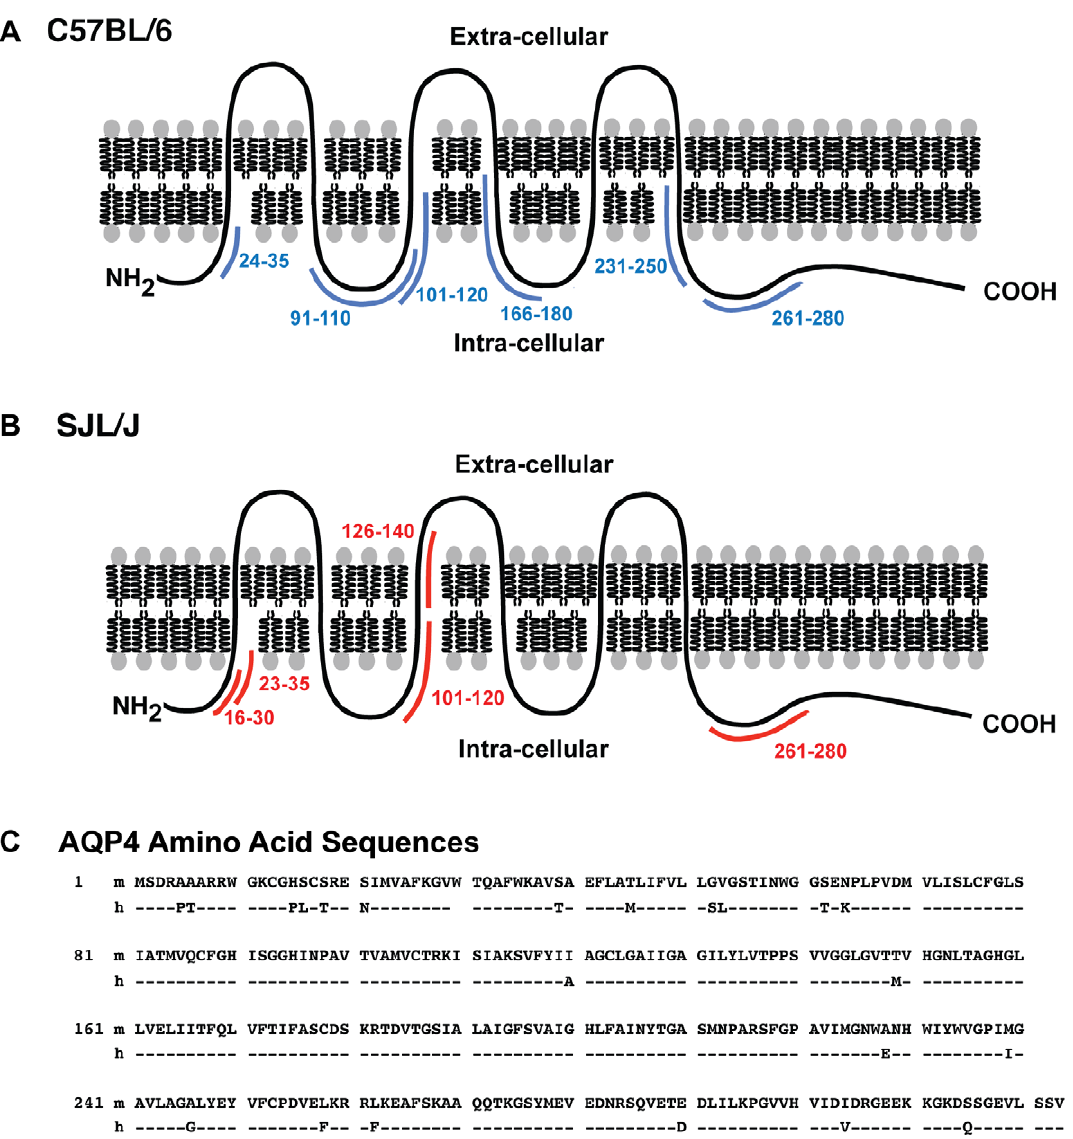
Figure 2. Localization of identified murine AQP4 T cell epitopes. AQP4 peptides that elicited proliferative responses in (A) C57BL/6 and (B) SJL/J mice are located within putative transmembrane and cytoplasmic domains. (C) Sequences of human (hAQP4) [34] and murine [17] AQP4 (mAQP4). Dashes represent homologous regions between the two species.